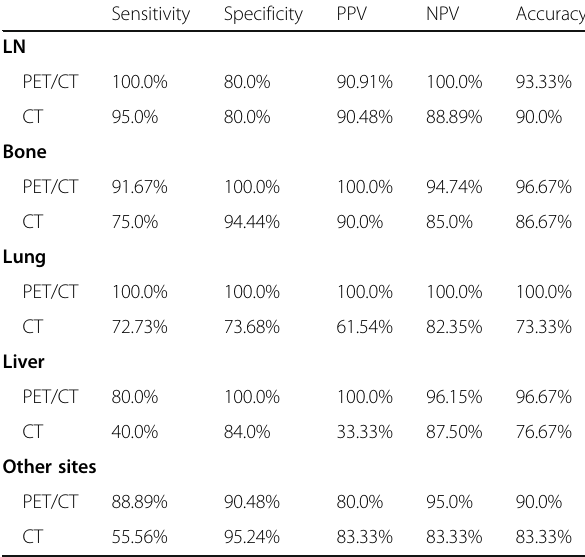
Table 5 Sensitivity, specificity, accuracy, and positive and negative predictive values of FDG-PET/CT and contrast- enhanced CT in lymph nodes, bone, lung, liver, and other visceral metastasis